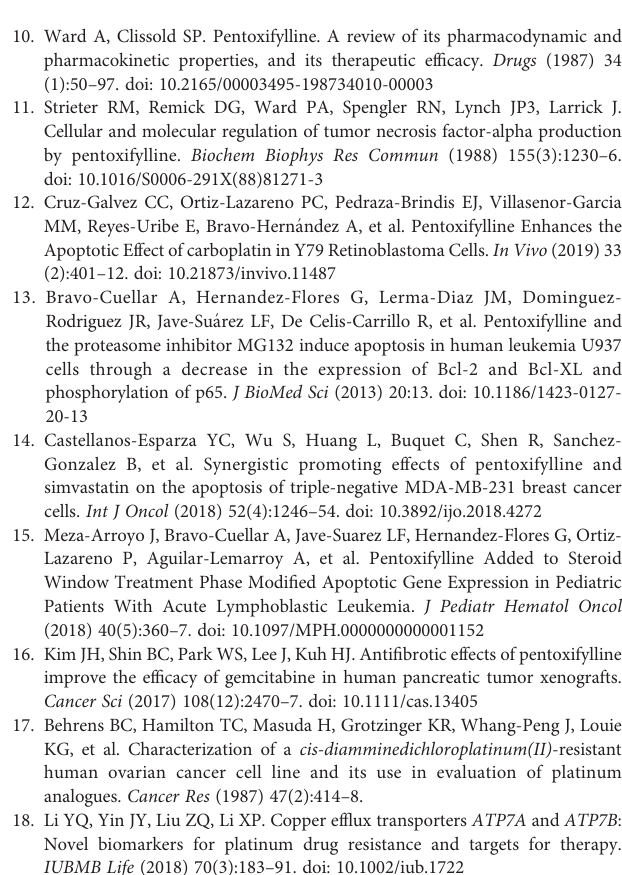
SUPPLEMENTARY FIGURE 1 | IC50 values for Cisplatin in cervical cancer cells were determined by the SRB assay. Comparison of the dose-response curves for CIS in HeLaCIS-R cells (A) , HeLaP cells (B) , SiHaCIS-R cells (C) , and SiHaP cells (D) . Each point represents the mean ± Standard Deviation (SD) of three independent experiments, each performed in triplicate. SUPPLEMENTARY FIGURE 2 | IC50 values for Pentoxifylline in cervical cancer cells were determined by the SRB assay. Comparison of the dose-response curves for PTX in HeLaCIS-R cells (A) , HeLaP cells (B) , SiHaCIS-R cells (C) , and SiHaP cells (D) . Each point represents the mean ± Standard Deviation (SD) of three independent experiments, each performed in triplicate. SUPPLEMENTARY FIGURE 3 | A representative example of a strategic analysis of p65 phosphorylation, Bcl-XL, and Bcl-2 expression by fl ow cytometry is